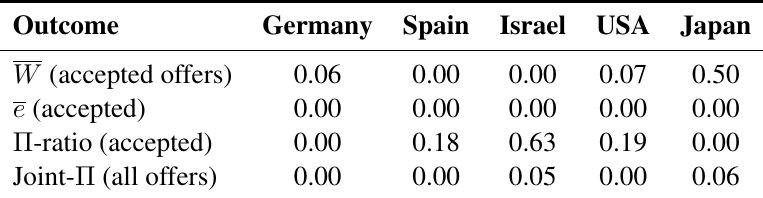
Table B3. The impact of repetition within each